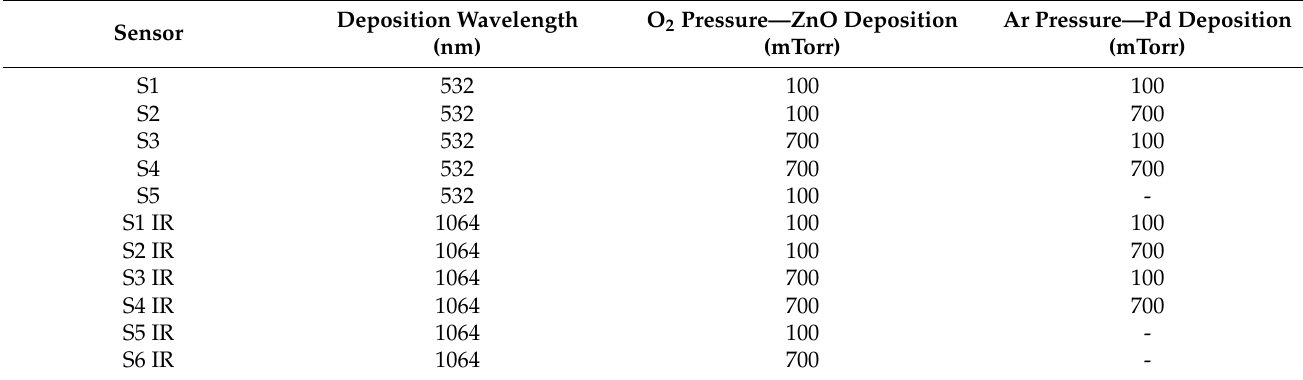
Table 1. Conditions for deposition of the components of the sensitive films for the sensors that were measured. Sensors S5, S5 IR and S6 IR have a sensitive layer consisting in a single ZnO layer. Sensor